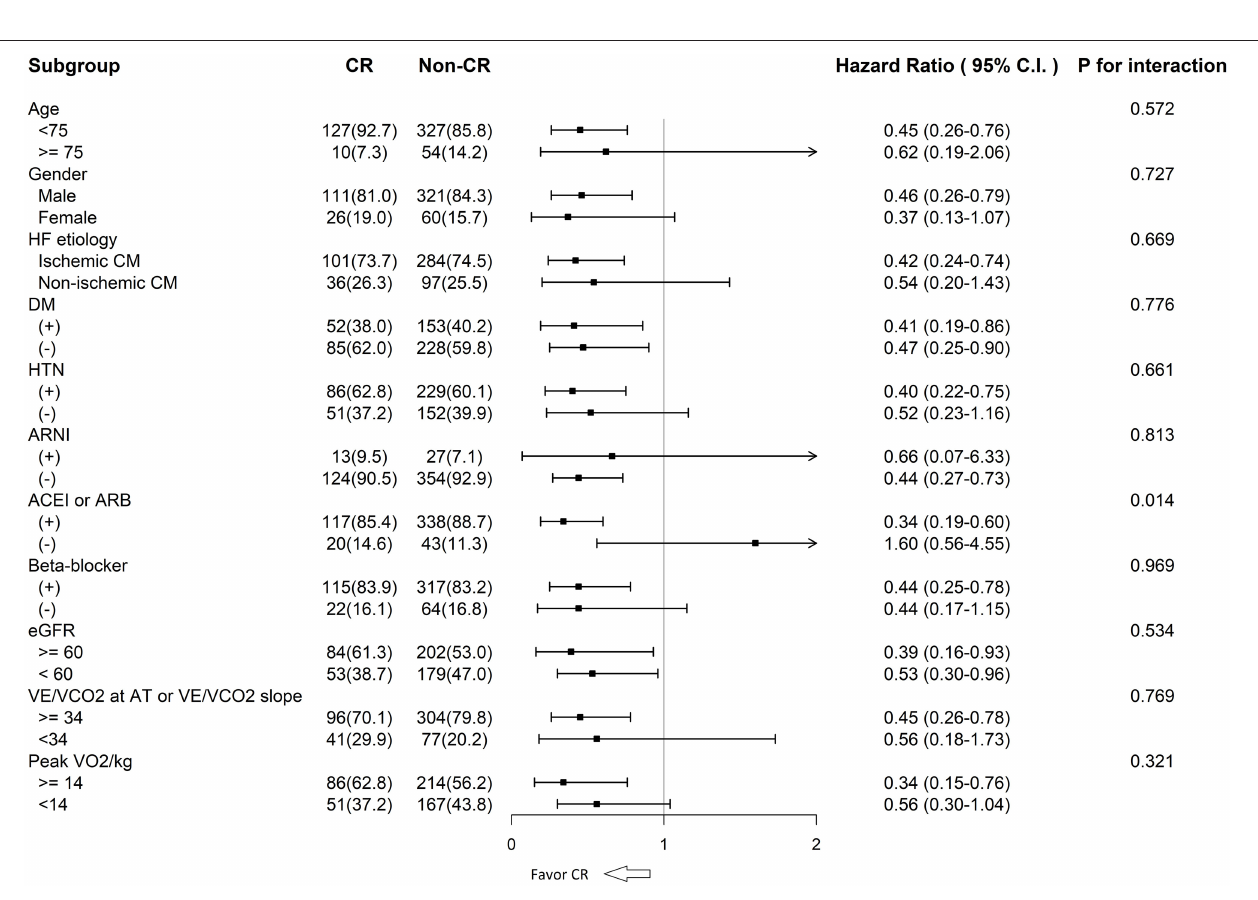
FIGURE 3 | CR and all-cause mortality among the subgroups. CR, cardiac rehabilitation; HF, heart failure; CM, cardiomyopathy; DM, diabetes mellitus; HTN, hypertension; ARNI, angiotensin receptor neprilysin inhibitor; ACEI, angiotensin converted enzyme inhibitor; ARB, angiotensin II receptor blocker; eGFR, estimated glomerular filtration rate; VE/VCO 2 , ventilatory equivalent for carbon dioxide; AT, anaerobic threshold; VO 2 /kg, oxygen consumption per kilogram.